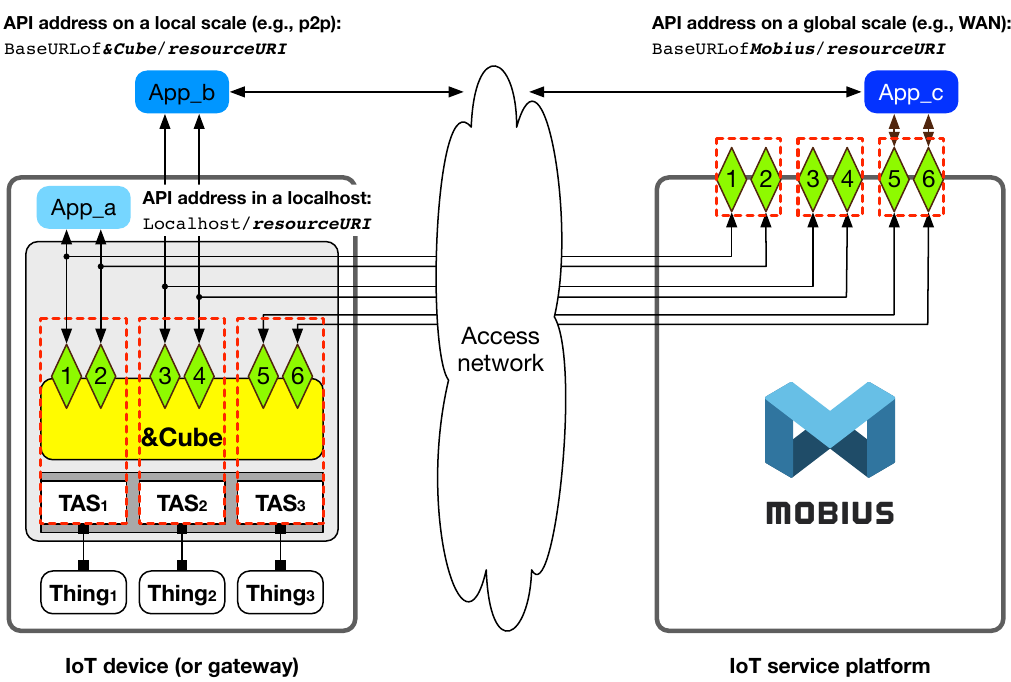
Figure 8. Application development support with Mobius and &Cube on several scales: localhost, local scale, and global